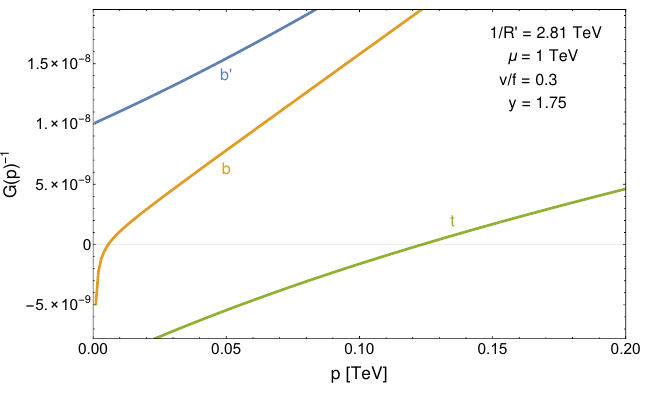
Figure 13 . Top, bottom and b 0 inverse Green’s functions. The zero modes of t and b are lifted in the presence of the Higgs VEV.